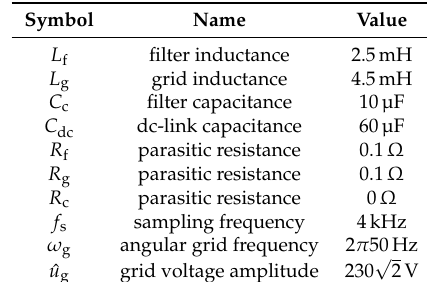
Table 2. Parameter values, taken from the test bench.